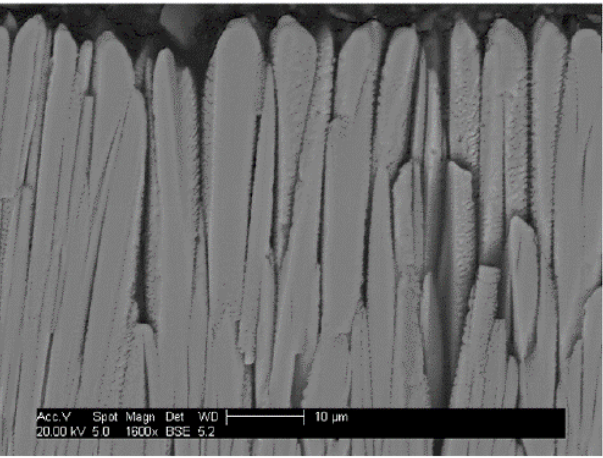
Figure 11. Cross-sectional view of as deposited electron beam-physical vapor deposition (EB-PVD) TBC microstructure (reproduced with permission from [63], Elsevier, 2015).